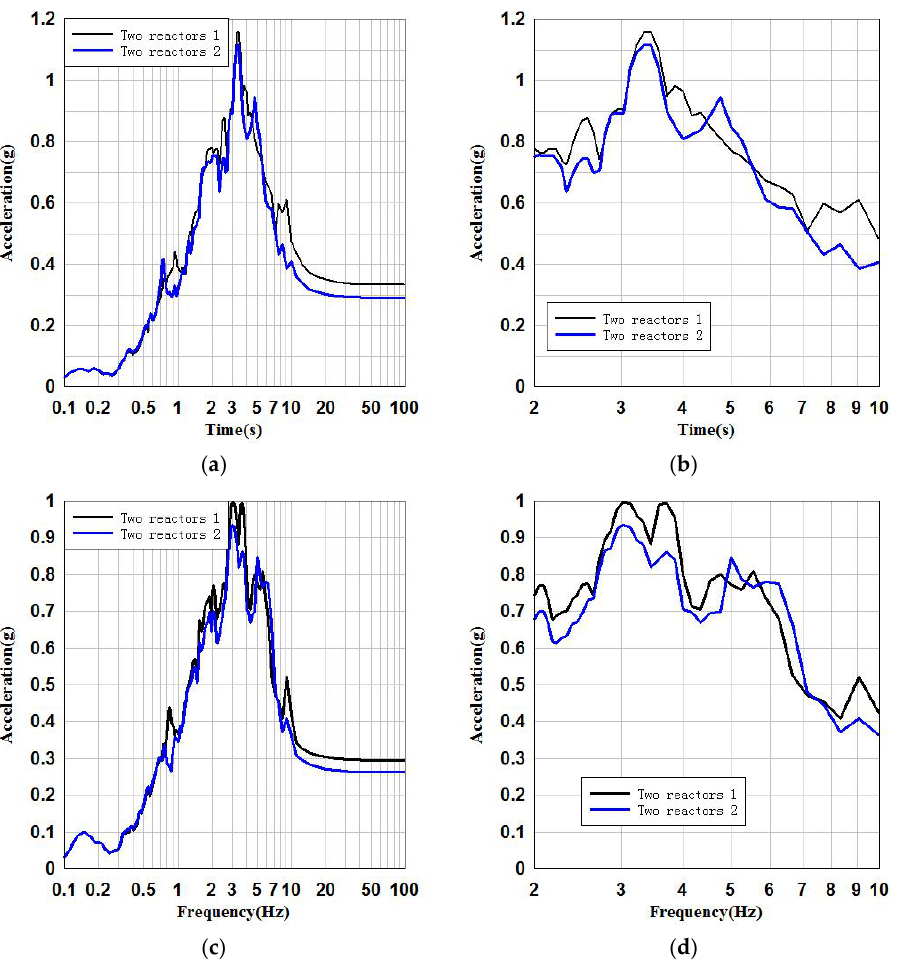
Figure 9. Comparison of FRS of key floor reference points in x and y directions. ( a ) FRS of the key floor in the x direction. ( b ) FRS of the key floor in the x direction (2–10 Hz). ( c ) FRS of the key floor in the y direction. ( d ) FRS of the key floor in the y direction (2–10 Hz).